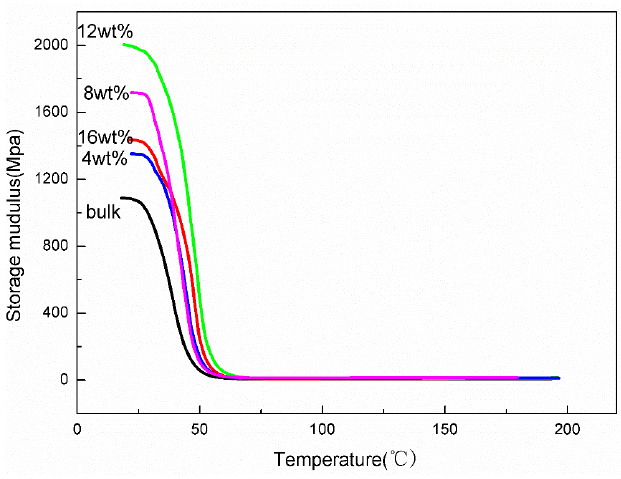
Figure 6. Storage modulus of SiCw/hydro-epoxy composites.